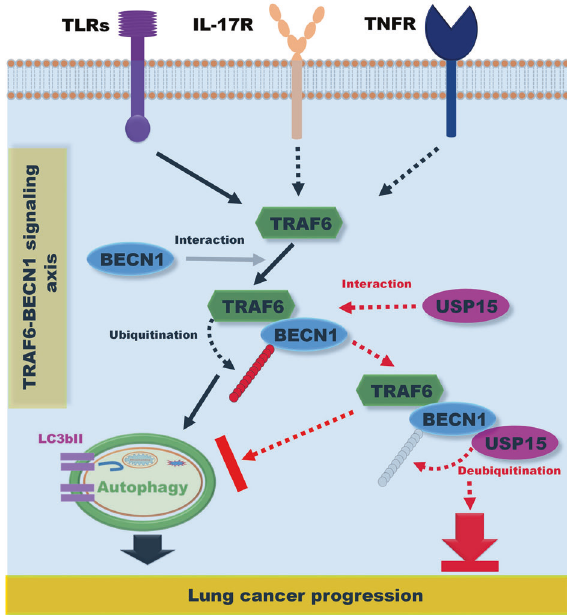
Fig. 9 A schematic model showing how USP15 regulates lung cancer progression by regulating the TRAF6-BECN1 signaling axis for the induction of autophagy. Upon cellular stimuli including TLRs, IL-17R, and TNFR, TRAF6 functionally regulates the occurrence and development of tumors through various cellular events, such as cell apoptosis, proliferation, survival, and invasion. Regarding the TRAF6-BECN1 signaling axis for cancer progression (depicted in the left), TRAF6 can interact with BECN1 and induce ubiquitination of BECN1, leading to the induction of autophagy (indicated as a black arrow). UPS15 can interact with BECN1 and induce deubiquitination of BCEN1, thereby inhibiting the induction of autophagy (indicated as red dashed arrow). Eventually, USP15 is negatively implicated in lung cancer progression by inhibiting the TRAF6-BECN1 signaling